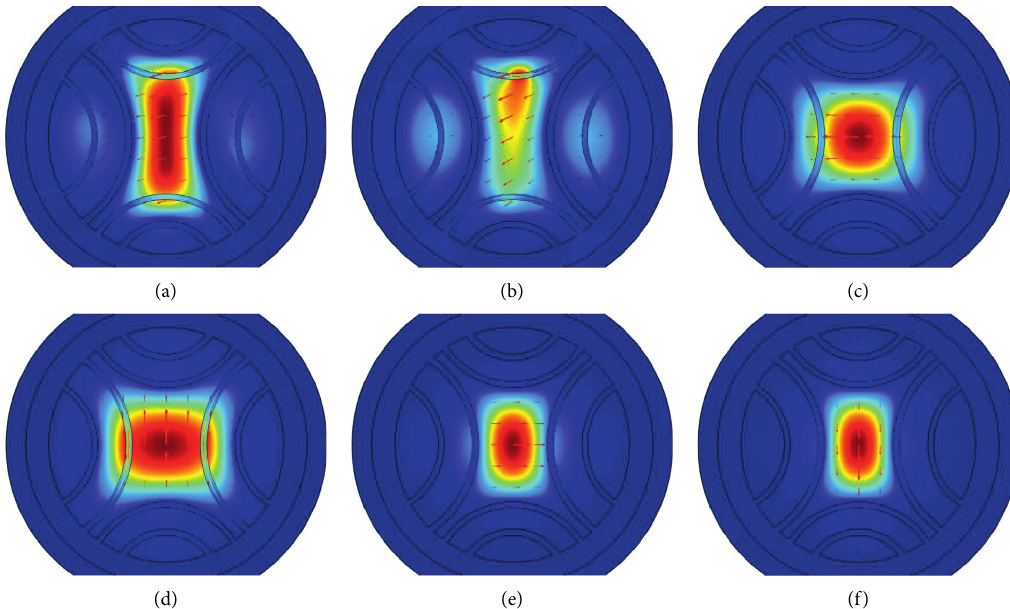
Figure 3: (a) x -polarized mode at 1.21 μ m. (b) y -polarized mode at 1.21 μ m. (c) x -polarized mode at 1.42 μ m. (d) y -polarized mode at